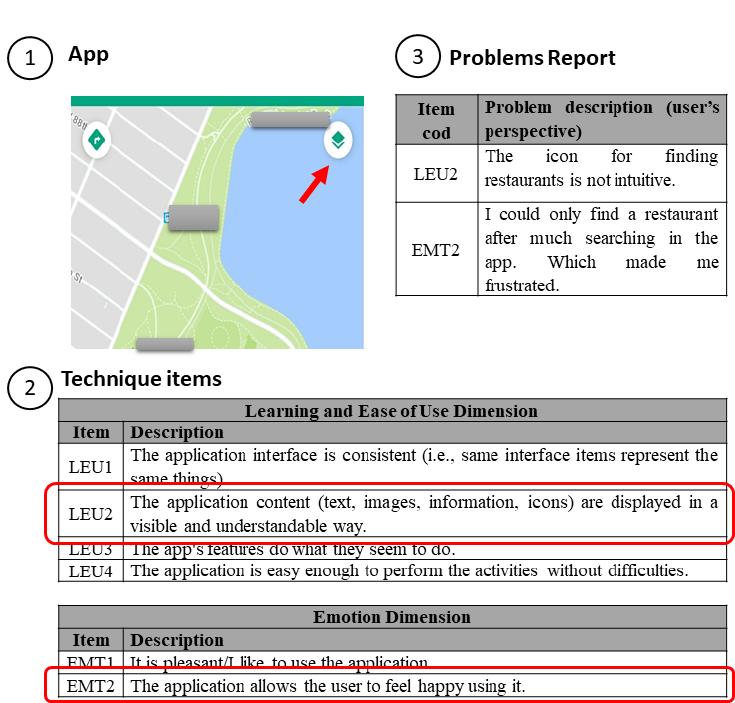
Figure 4. A practical example of using